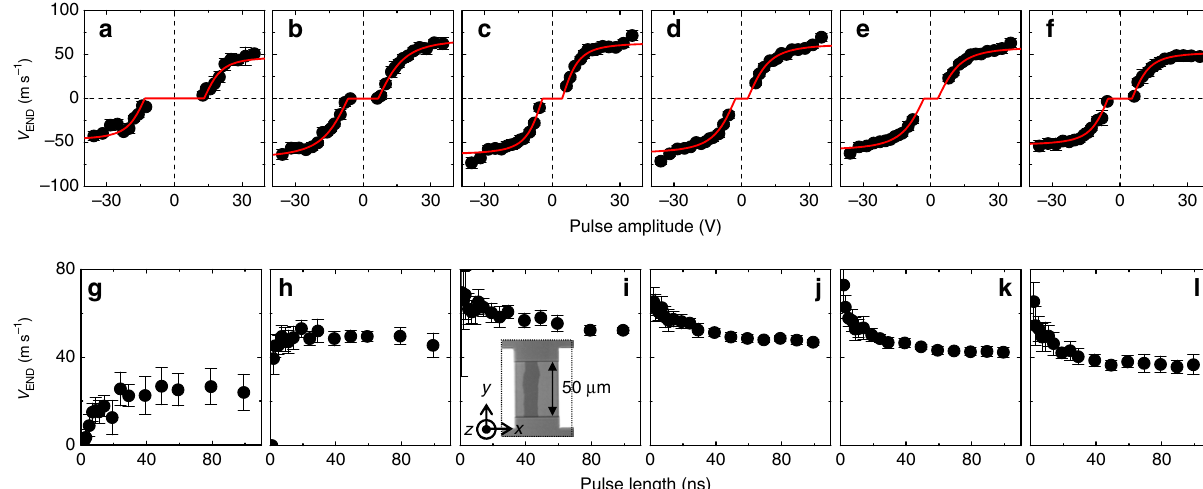
Figure 1 | Pulse amplitude and pulse length-dependent domain wall (DW) velocity. ( a – f ) Quasi-static DW velocity v END plotted against pulse amplitude for a fixed pulse length ( t P ¼ 10ns). The red solid line represents fitting with the 1D model (equation (1)). ( g – l ) Pulse length dependence of v END for fixed pulse amplitude ( ± 16V). Symbols represent the average | v END | for both positive (16V) and negative ( (cid:2) 16V) pulse amplitudes. The W layer thickness d varies for a – f and g – l as 2.3, 2.6, 3.0, 3.3, 3.6, 4.0nm. Inset of i : representative optical (Kerr) microscopy image of the device and the definition of the coordinate axis. All results are from film set A, wire width is B 50 m m. The error bars represent standard deviation of the velocity estimated in three sections of the wire (see Methods for the definition of the